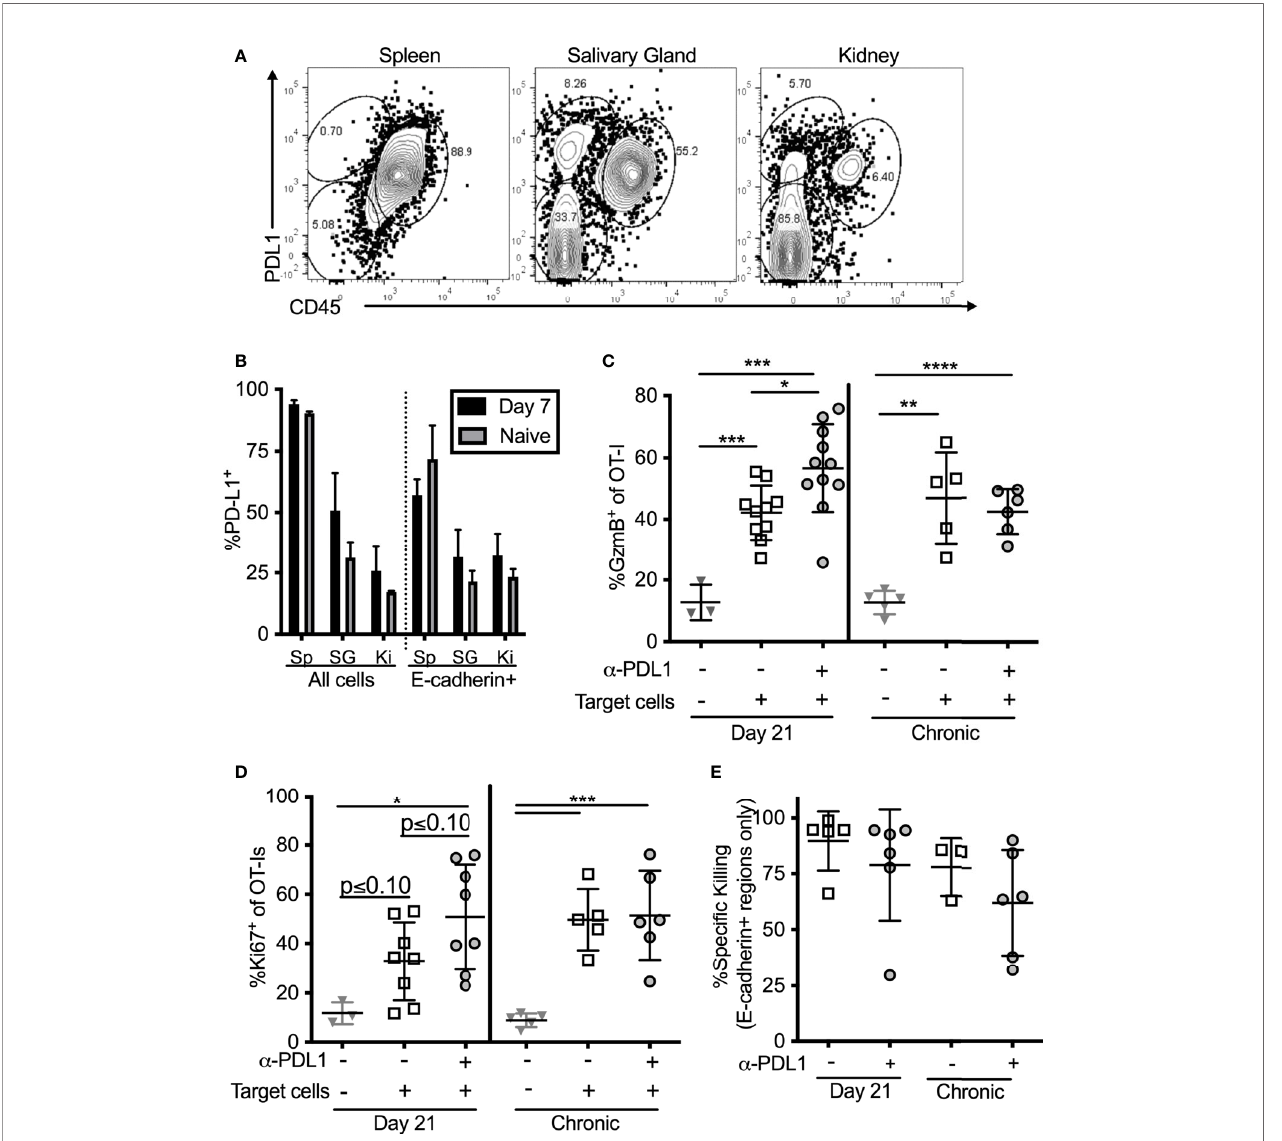
FIGURE 7 | T cell stimulation by PD-L1 expressing target cells. (A, B) Organs from naïve mice and mice infected with wildtype MCMV for 7 days were homogenized as described in the methods, and directly stained for PD-L1 expression without Percoll isolation. (A) Representative FACS plots of PD-L1 expression on all cells recovered from salivary glands. (B) Frequency of PD-L1 expression on different subtypes of cells in the indicated organs. Data are representative of 3 mice per group. (C – E) Mice bearing OT-Is and infected with MCMV-OVA for either 21 days, or more than 12 weeks, received the PD-L1 blocking antibody or an isotype control antibody for two weeks. At the end of the blocking period, splenocytes from naïve mice were pulsed with either SIINFEKL or an irrelevant peptide (B8R) and labelled with CellTrace Far Red or CFSE respectively. Target cells were injected i.v. and intra-glandularly into 48 hours after target cell injection, tissues were harvested for analyses. Half of the harvested organs were used to extract lymphocytes for FACS analysis and half were frozen for immuno fl uorescent histology. Shown is the frequency of (C) granzyme B expression and (D) Ki-67 expression by salivary gland localized OT-Is as assessed by FACS. In all cases, data were analyzed in pairwise fashion between groups of mice treated or not with the PD-L1 blocking antibody using unpaired, two-tailed t-tests. (E) Speci fi c killing of peptide pulsed splenocytes contained withing E-cadherin + regions of the salivary gland as assessed by histology (n=6-11 mice from 4 independent experiments). *p ≤ 0.05, **p ≤ 0.01, ***p ≤ 0.001, ****p ≤